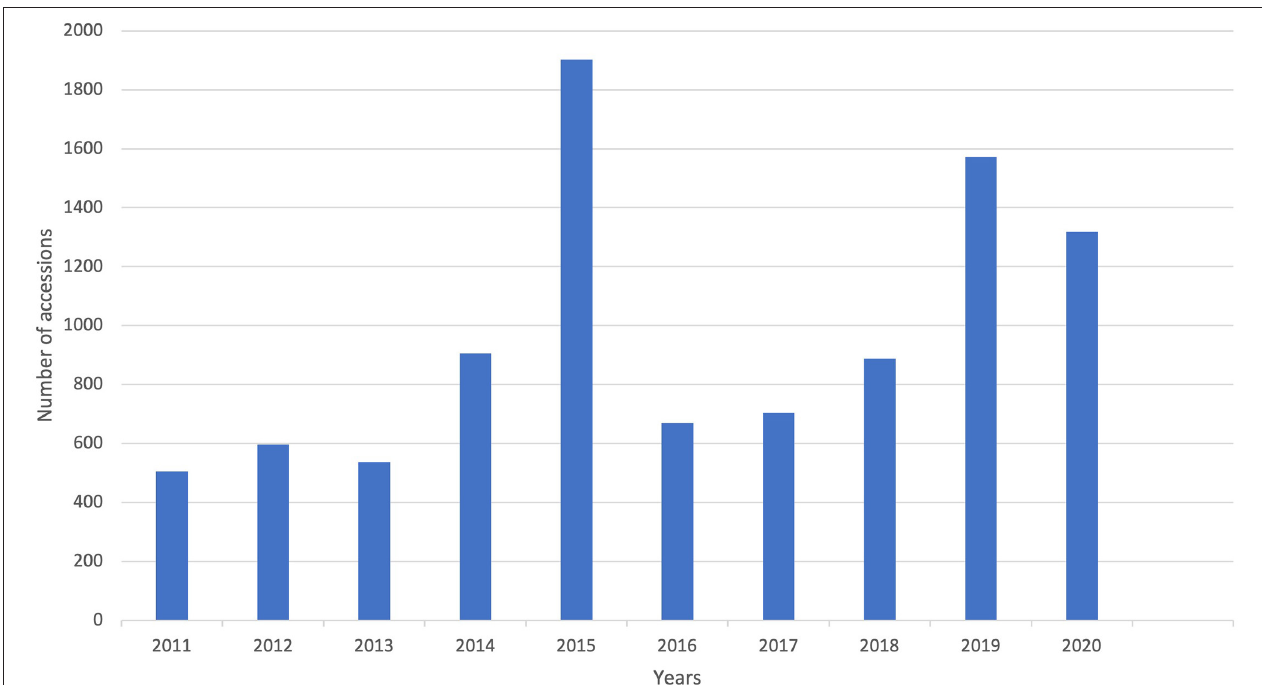
FIGURE 6 | The number of distributed germplasm samples of orphan legumes in IITA genebank in last 10 years.